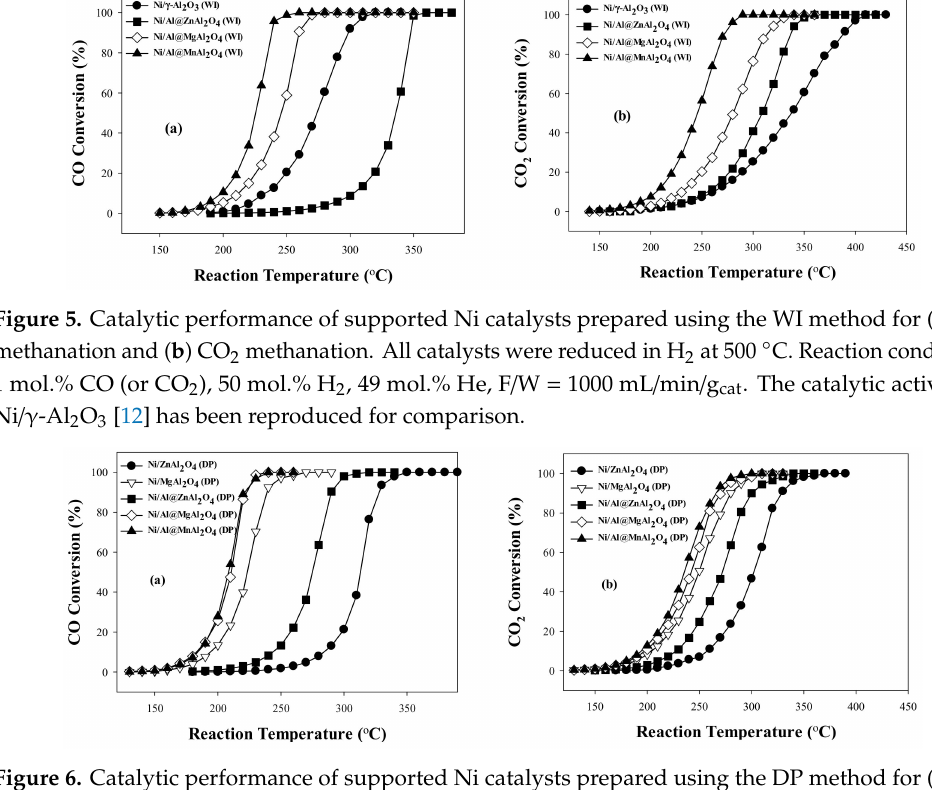
Figure 6. Catalytic performance of supported Ni catalysts prepared using the DP method for ( a ) CO methanation and ( b ) CO 2 methanation. All catalysts were reduced in H 2 at 500 ◦ C. Reaction conditions: 1 mol.% CO (or CO 2 ), 50 mol.% H 2 , 49 mol.% He, F / W = 1000 mL / min / g cat